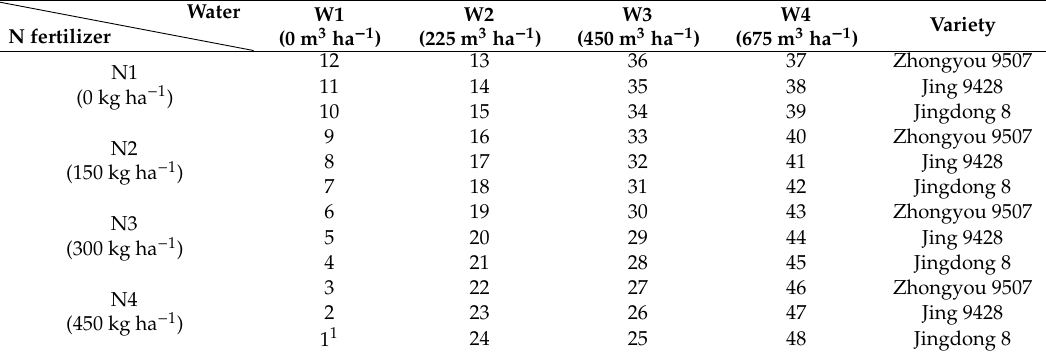
Table 1. Descriptions of the winter wheat experimental design in